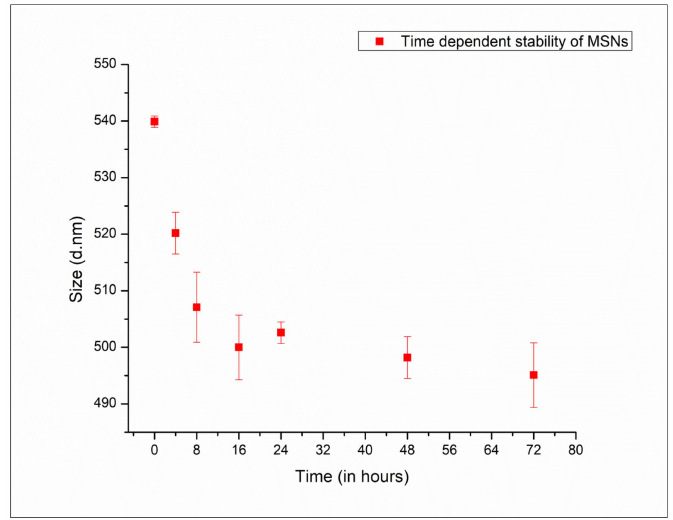
Figure 3. The stability of the synthesized MSNPs analyzed using DLS over a time period of 72 h at room temperature (25 ± 2 ◦ C).